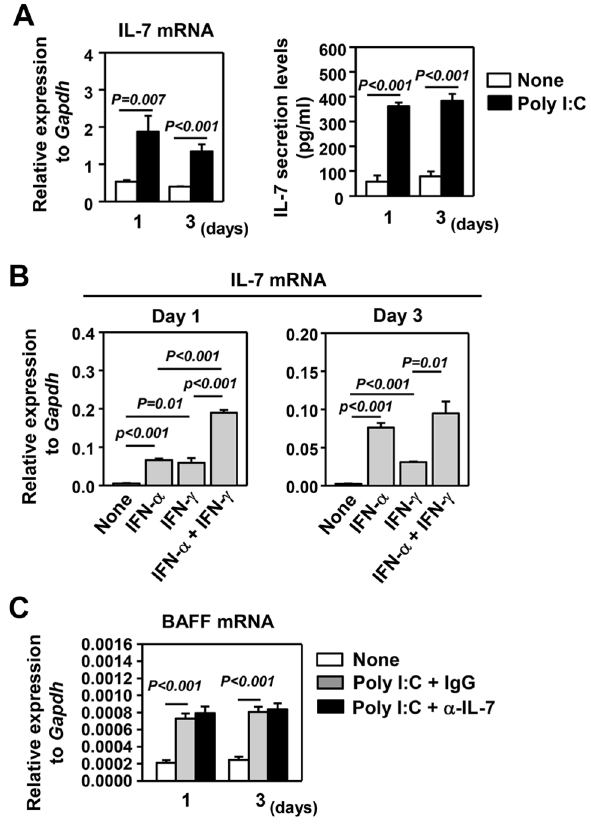
Figure 6. Poly I:C induces production of IL-7 in human salivary gland epithelial cells. (A) HSG cells were cultured in vitro with or without poly I:C for 1 and 3 days. IL-7 mRNA levels, left panel, and protein concentrations in culture supernatants, right panel, assessed by real time PCR and ELISA, respectively. (B) HSG cells were treated with IFN-α, IFN-γ or both for 1 and 3 days, and then measured for IL-7 mRNA levels. (C) HSG cells were treated with poly I:C in the presence of control IgG or anti-human IL-7 for 1 or 3 days, and then measured for BAFF mRNA expression. All PCR results are presented relative to that of GAPDH. All data are the average of analyses of 6 independent samples for each group (3 samples per experiment, total 2 independent experiments). doi: not RAG1 -/- mice that lack T cells [28,32]. Therefore, IL-7 increases IFN-γ expression in salivary glands and lungs in a T cell-dependent manner, likely by enhancing Th1 and Tc1 responses. It is hence conceivable that, at the later stage after poly I:C treatment, poly I:C-induced IL-7 can act on salivary gland-infiltrating Th1 and Tc1 cells to enhance IFN-γ production, which in turn reinforces IL-7 production in salivary glands in a positive feed-forward manner. Hence, we propose a two-step model for the CXCR3 ligand-induction and T cell infiltration in salivary glands in response to poly I:C stimulation, with NK cells acting in the first, initiating step and IL-7 and T cells acting in the second, amplifying step.